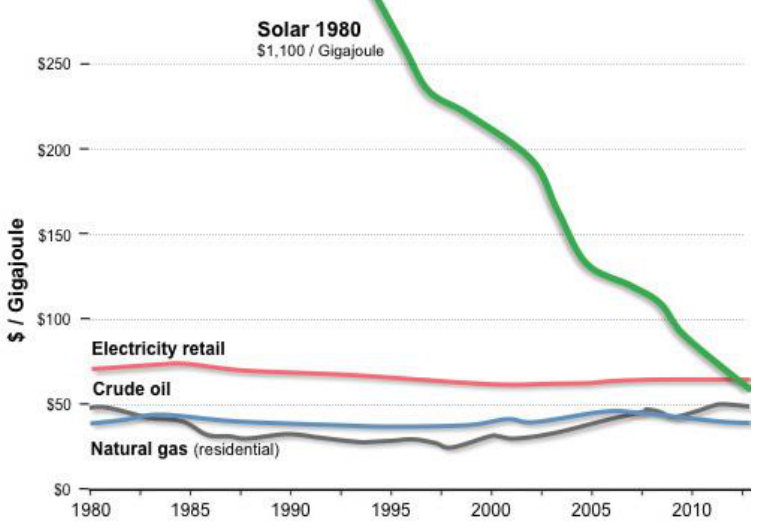
Figure 1. Solar prices in the U.S. have declined; fossil fuel prices (adjusted for inflation) have not [13].